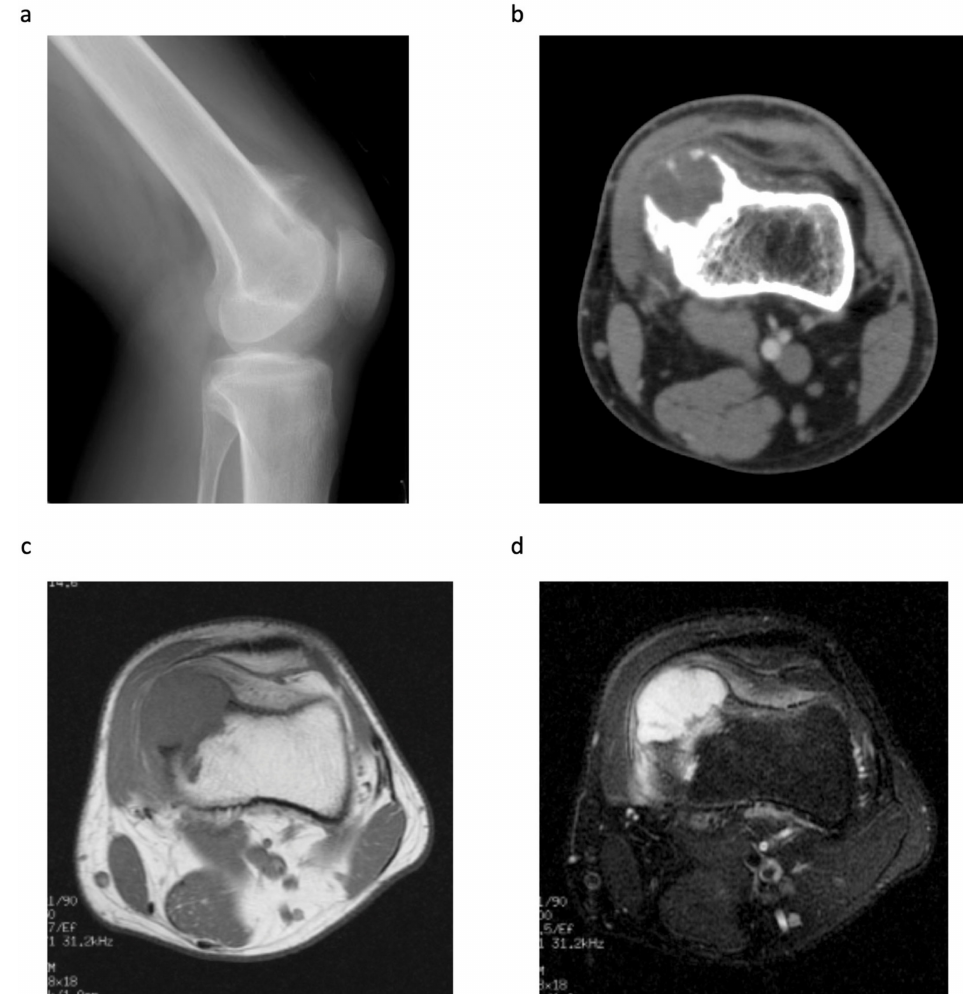
Figure 1. A 23-year-old male with a pathological diagnosis of periosteal chondrosarcoma (Case 3). ( a ) Lateral radiograph of the left knee showing a lobulated calcified mass on the anterior aspect of the distal metaphysis of the femur. ( b ) CT showing the medial periosteal-based lesion with a calcified shell. The cortex is thickened, but there is no evidence of medullary invasion. ( c ) T1-weighted MRI showing a lobulated mass (6.0 × 4.0 × 3.0 cm), with low signal intensity, arising from the periosteum. ( d ) T2-weighted fat suppressed MRI showing a predominantly high signal intensity mass with medullary invasion. Adjacent soft tissue oedema is also